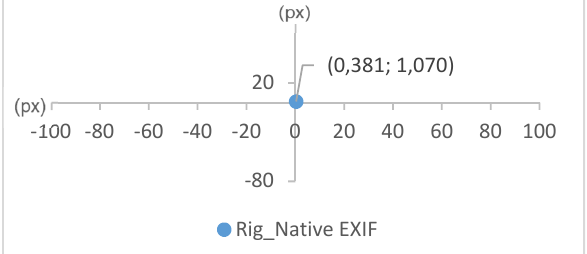
Figure 6. Estimated principal point coordinates of the six cameras mounted on the rig and automatically processed with the native Exif information.